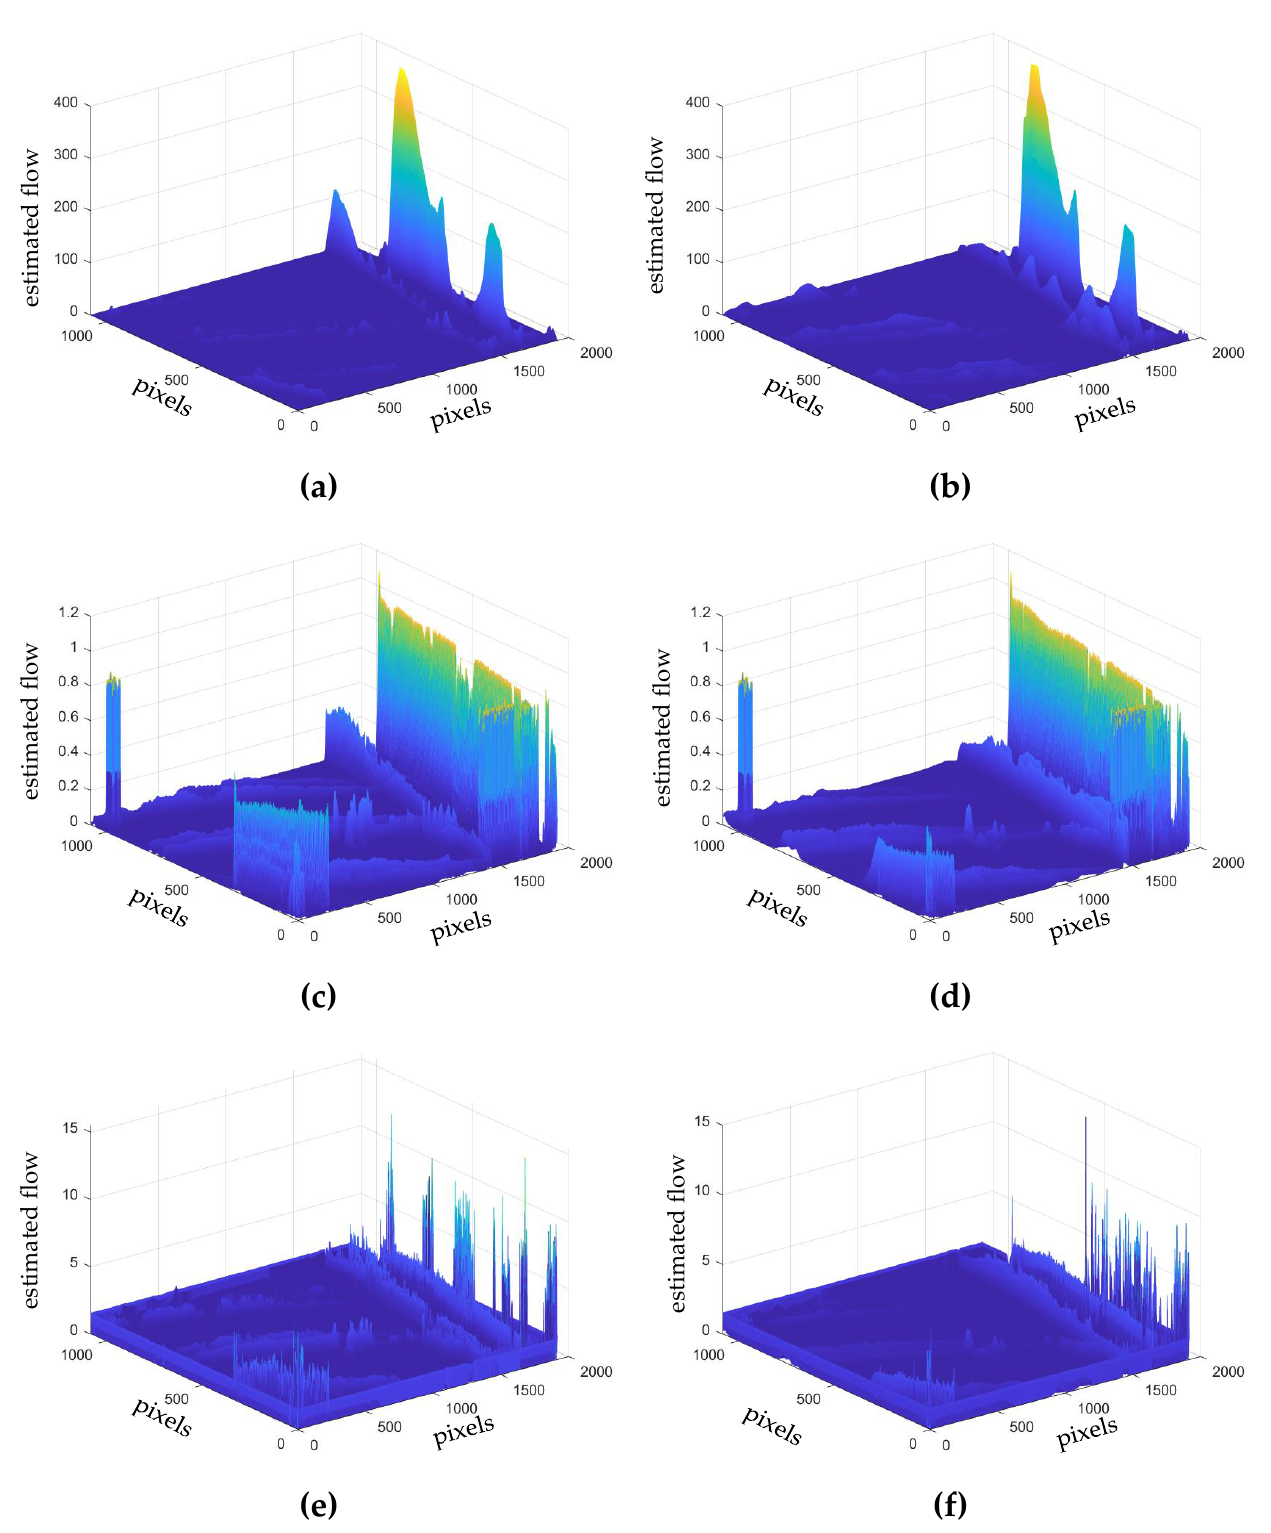
Figure 5. Sample averaged optical flows obtained for two different water flow velocities: ( a ) Farneback method for 2.17 dm 3 /s; ( b ) Farneback method for 5.03 dm 3 /s; ( c ) HS method for 2.17 dm 3 /s; ( d ) HS method for 5.03 dm 3 /s; ( e ) LK method for 2.17 dm 3 /s; and ( f ) LK method for 5.03 dm 3